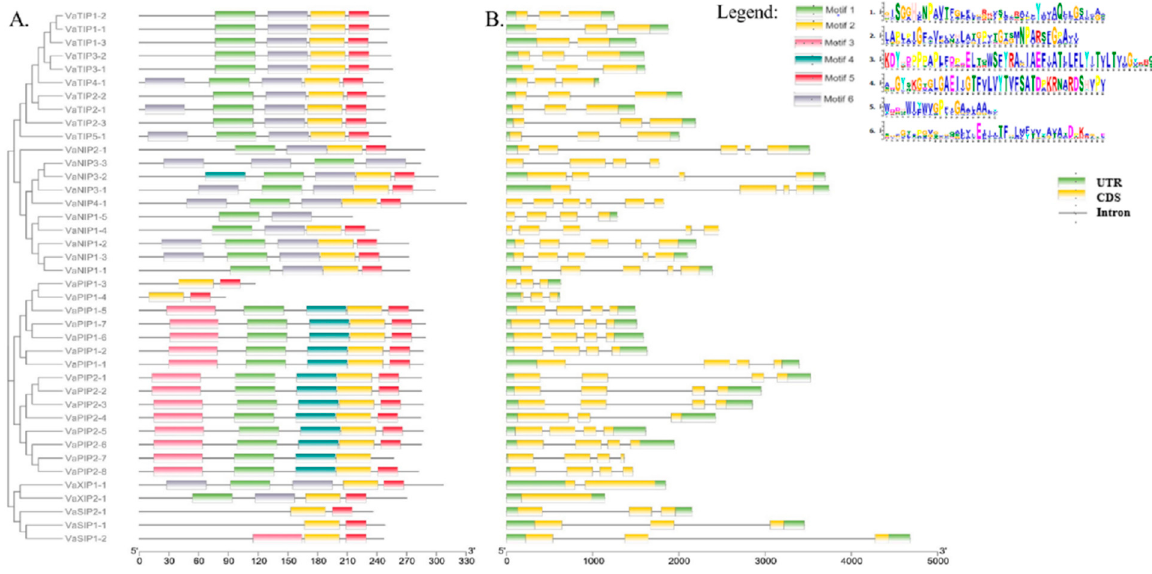
Figure 3. Conserved motifs of the VaAQPs proteins were identified using MEME. ( A ) Neighbor-joining evolutionary trees were generated using 1000 bootstraps, and a total of six motifs were identified